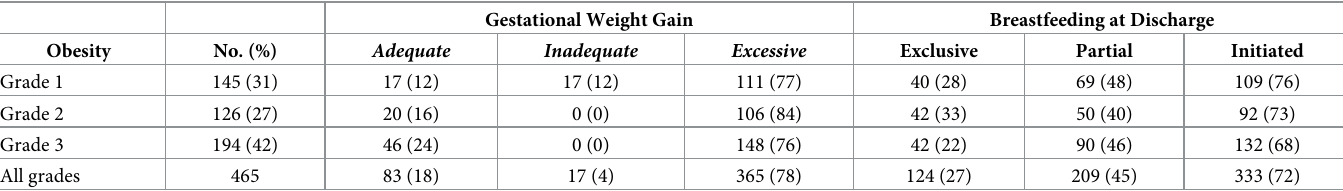
Table 4. Maternal obesity, gestational weight gain and infant feeding at